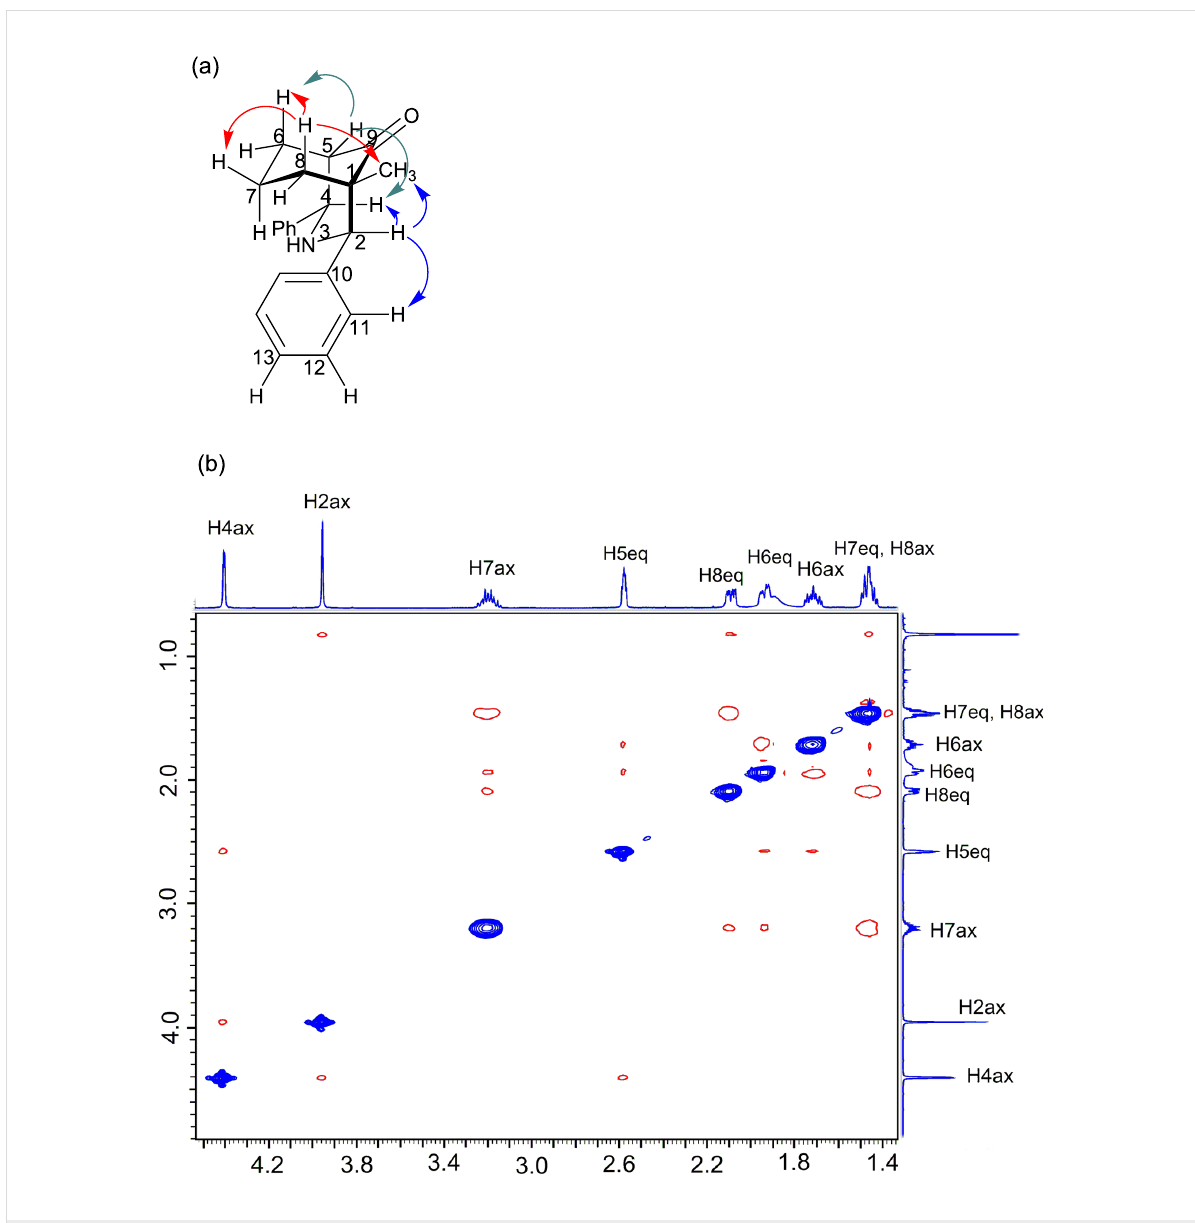
Figure 6: (a) Preferred conformation of 4 determined by nOe, (b) t-ROESY spectrum of 4 recorded at 500 MHz in CDCl 3 .